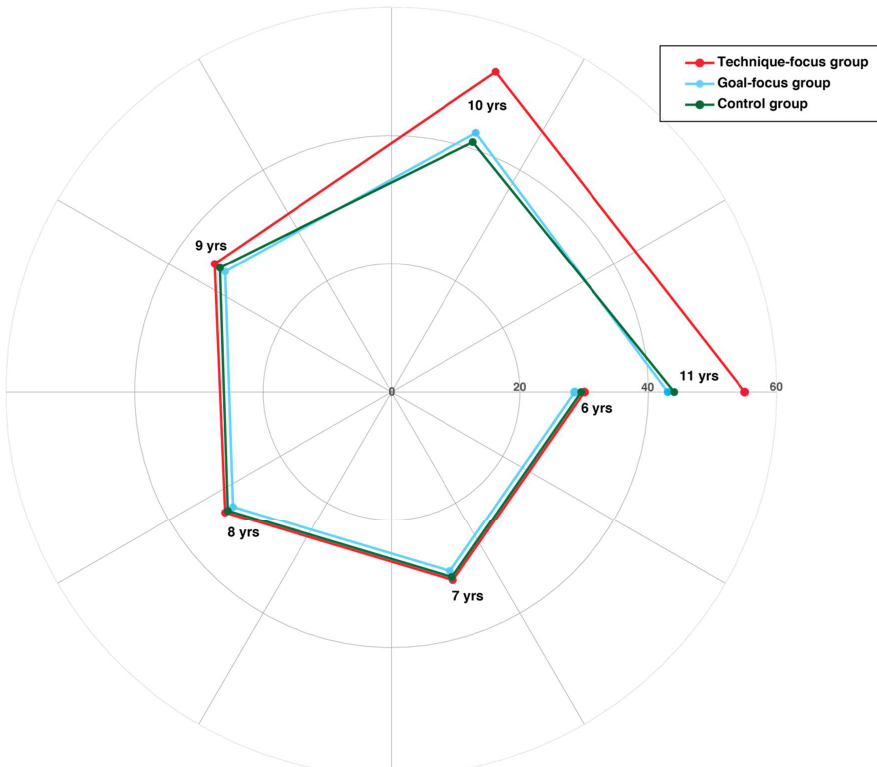
Figure 1. Polar diagram showing the mean scores obtained by all subjects for the PBT task during the practice phase. It is worth noting that while from age 6 to 9, the PBT scores were almost the same for all groups, subjects aged 10 and 11 of the technique-focus group (red line) performed the PBT task significantly better ( p < 0.001) than both the goal-focus (cyan line) and control groups (green line). However, for the retention phase, this effect was seemingly lost, as during this